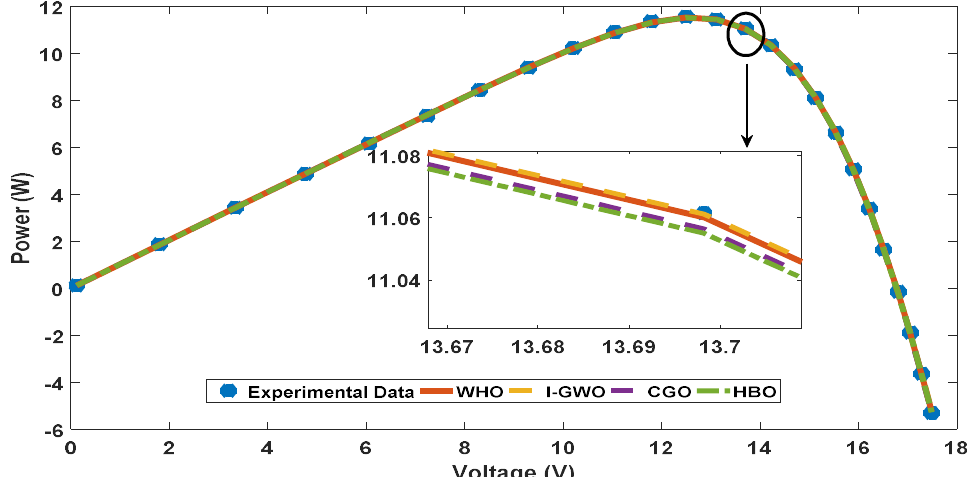
Figure 23. Power–voltage characteristic curve comparison between real data and all estimated TDM by different algorithms.